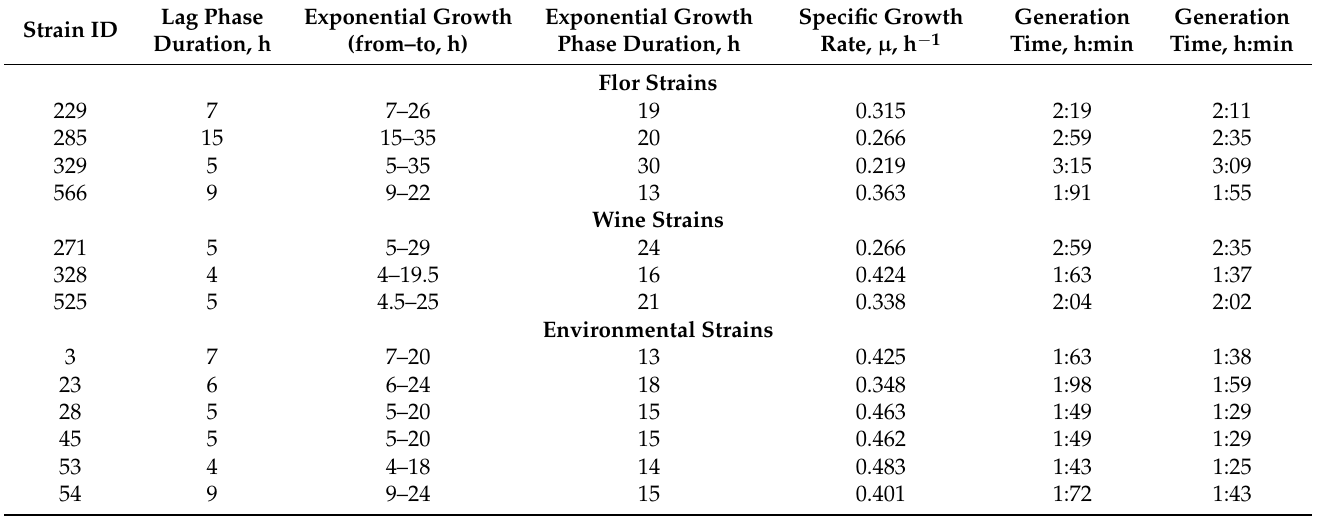
Table 2. Growth characteristics of